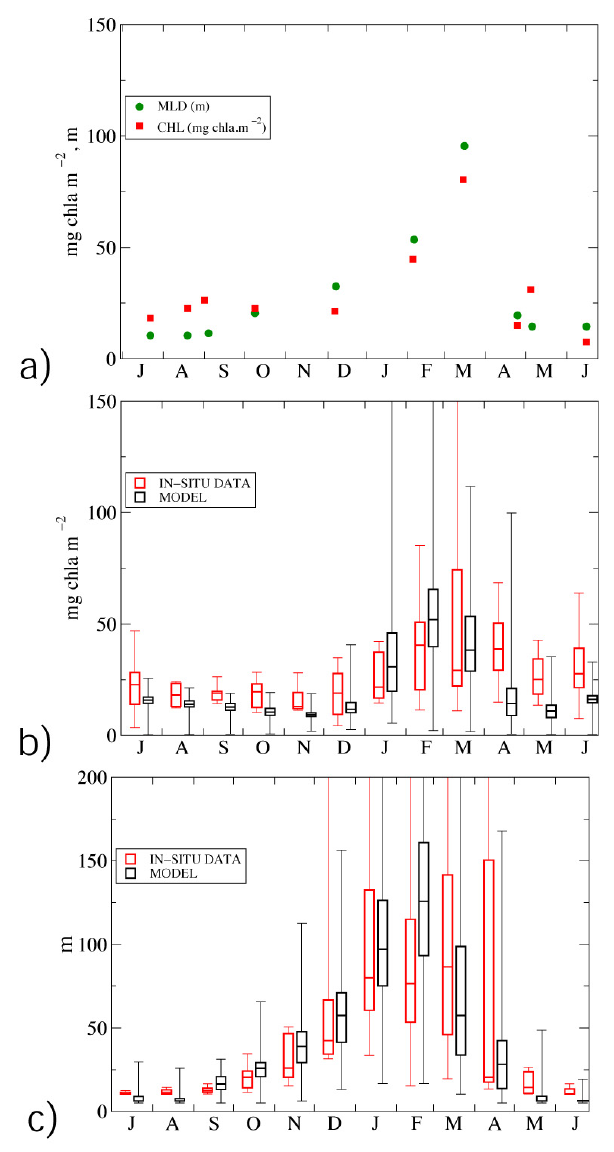
Fig. 5. (a) Seasonal cycle of integrated chlorophyll and mixed layer depth at DYFAMED station for the year 1998; (b) climatologi- cal seasonal cycle of integrated chlorophyll from in situ data and model results aggregated as monthly medians; (c) climatological seasonal cycle of mixed layer depth from in situ data and model results aggregated as monthly medians. In situ climatology data is derived from DYFAMED dataset for the period 1991–1999 (Marty and Chavi`erini, 2002). Model outputs are monthly medians for the period 1999–2004 considering a 1 degree box centered on DY- FAMED station position. Boxes values represent, from lower to higher values, minimum, 25th percentile, median, 75th percentile and